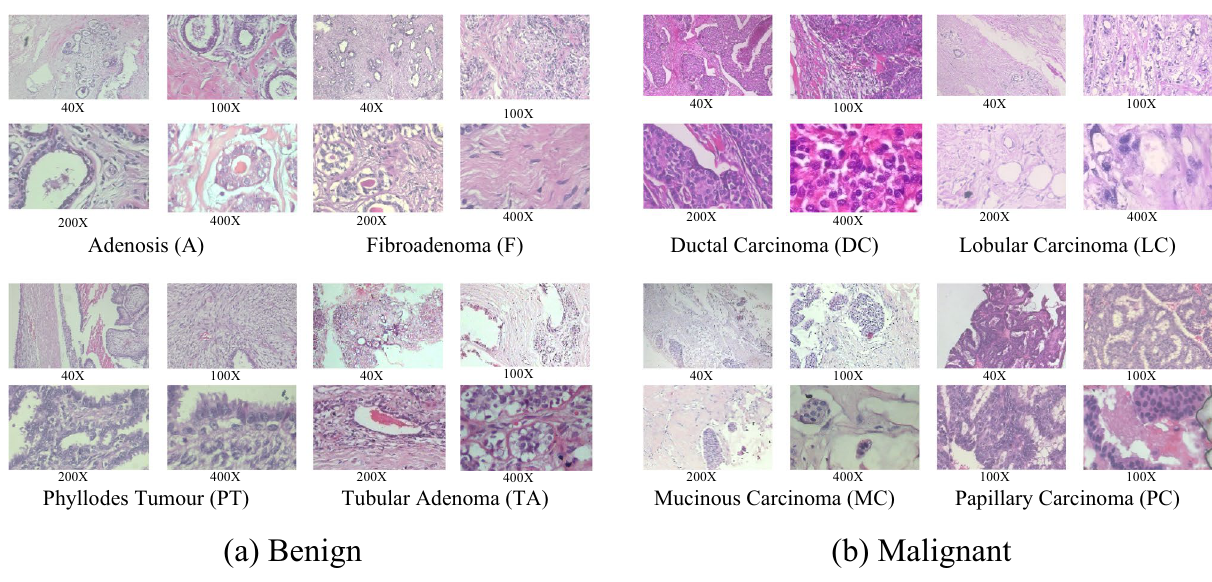
Figure 2. Samples slides of different breast tumour types (stained with H&E) under 40X,100X,200X, and 400X magnification factors from BreaKHis for two tumour classes: ( a ) benign, ( b ) malignant. Our research considers all histological images from the Benign class as “Grade 0”.